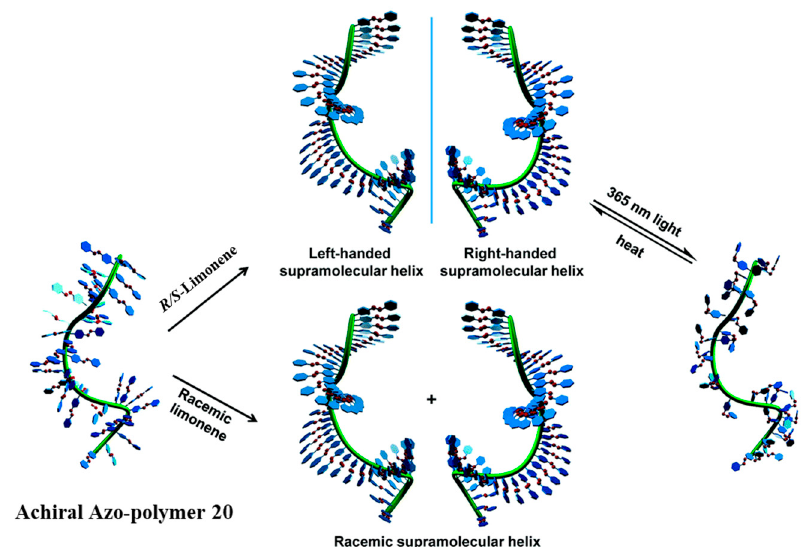
Figure 10. Illustration of the supramolecular helical structures of achiral Azo-polymer 20 induced by chiral limonene and the construction of the chiroptical switching. (Reproduced from [135] with permission from The Royal Society of Chemistry).